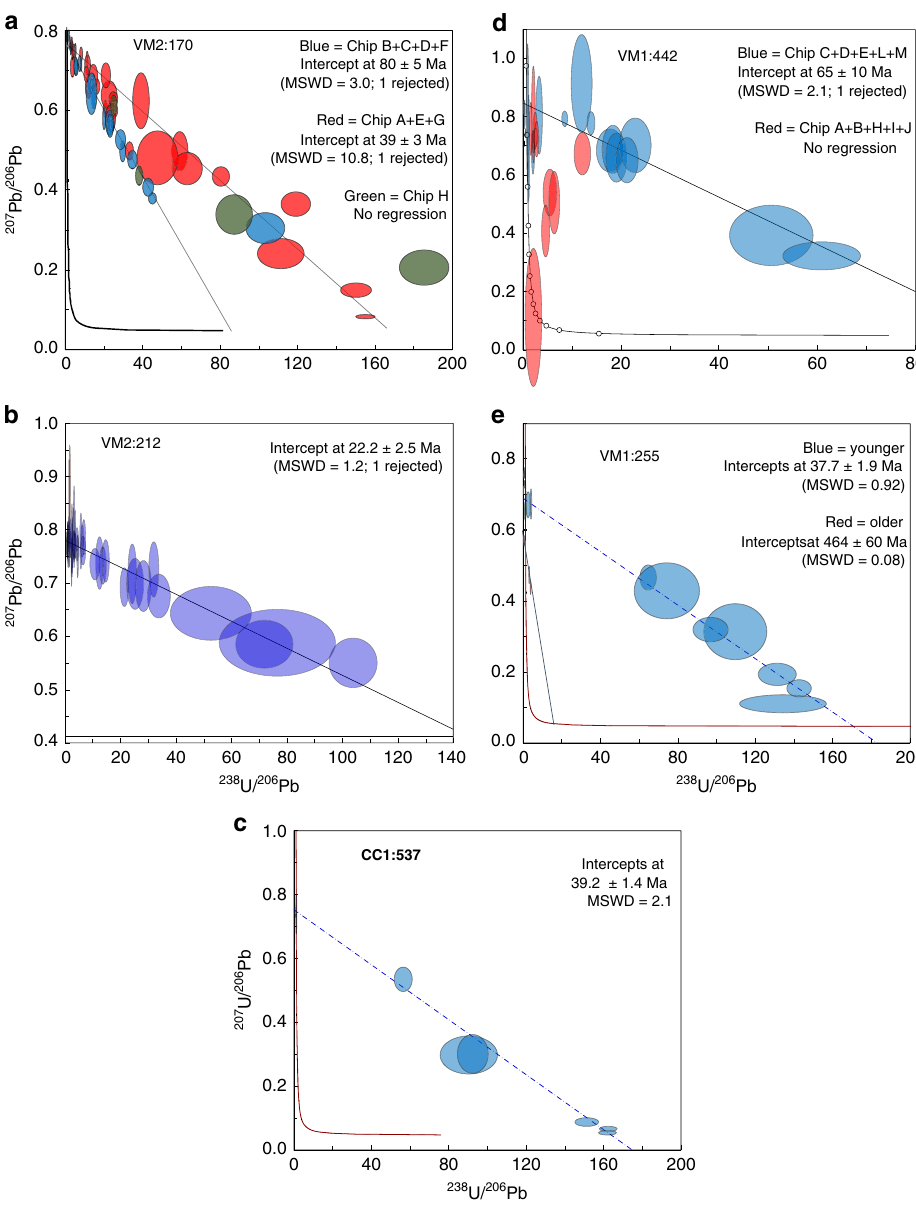
Fig. 5 U-Pb carbonate dating. a VM2:170, two generations of 13 C-rich calcite in limestone fracture, yielding ages 80 ± 5 Ma and 39 ± 3 Ma. b VM2:212 13 C- rich calcite in limestone fracture, yielding 22.2 ± 2.5 Ma. c CC1:537, 13 C-rich calcite, in granite fracture, yielding 39.2 ± 1.4 Ma. d VM2:442, 13 C-rich calcite in granite fracture, yielding 65 ± 10 Ma. e VM1:255, 13 C-depleted calcite in granite fracture (targeting the growth zones with dark BSE-intensity in Fig. 2n), yielding 37.7 ± 1.9 Ma, with an older potential event 464 ± 60 Ma (highly uncertain: only three data points). Errors represented by the ellipses are 2